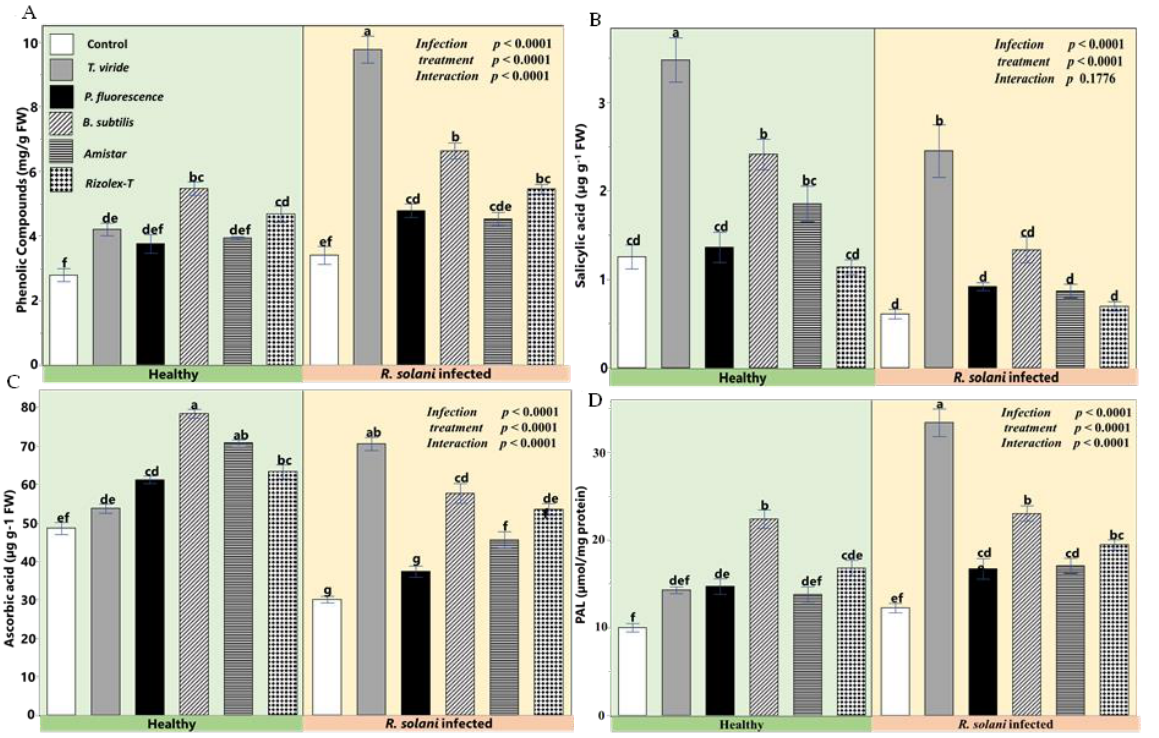
Figure 8. Effects of biocontrol agents on defense-related compounds in coriander infected by R. solani. ( A ) Total phenolics (µg g −1 FW), ( B ) salicylic acid (µg g −1 FW), ( C ) ascorbic acid (ASA) (µg g −1 FW), and ( D ) phenylalanine ammonia-lyase (PAL; a key SA biosynthesis enzyme) (µmol mg −1